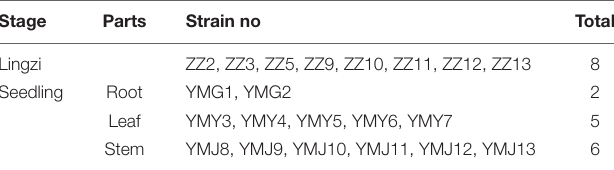
TABLE 1 | The result of separation of endophytic fungi from different parts of CX.